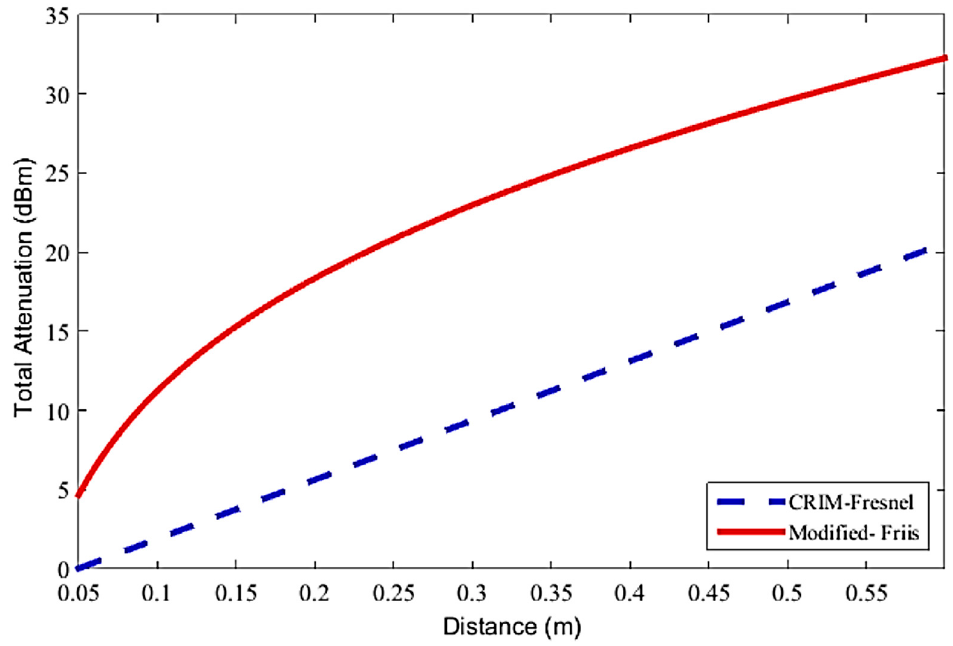
Figure 1. Comparison of modified-Friis and CRIM-Fresnel models.